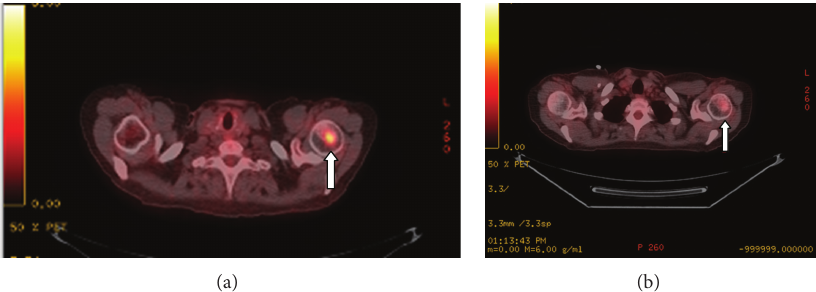
Figure 4: Axial PET-CT fusion image demonstrates an FDG-avid lesion in the left humeral head, consistent with a metastasis, labeled with an arrow (a). Postchemotherapy PET-CT axial image obtained just a few months later demonstrates complete metabolic response to the left humeral head lesion, labelled with an arrow